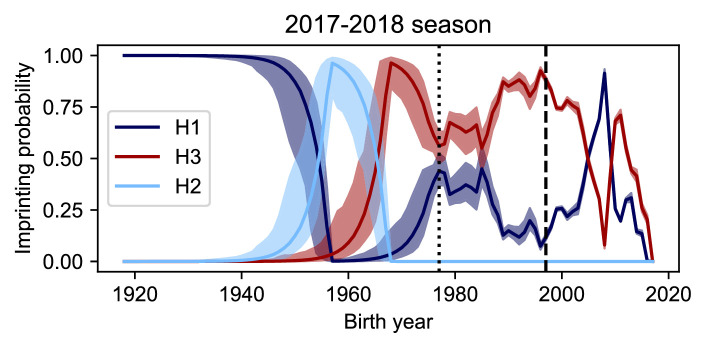
Imprinting probabilities with random sampling of seasonal intensity.Uncertainty in ILI and the frequency of A have a small impact on imprinting probabilities. We simulated 10000 datasets to represent the range of possible epidemic sizes for seasons where we did not have data on either ILI or the frequency of influenza A (Appendix 1: ‘Sensitivity to uncertainty in ILI and the frequency of influenza A’). The vertical dashed line shows the point at which data on ILI and the frequency of influenza A are available while the vertical dotted line shows the point at which data on only the frequency of A is available. The median imprinting probabilities for those simulations is shown as a solid line with the maximum and minimum imprinting probabilities shown by the bounds of the shaded area.